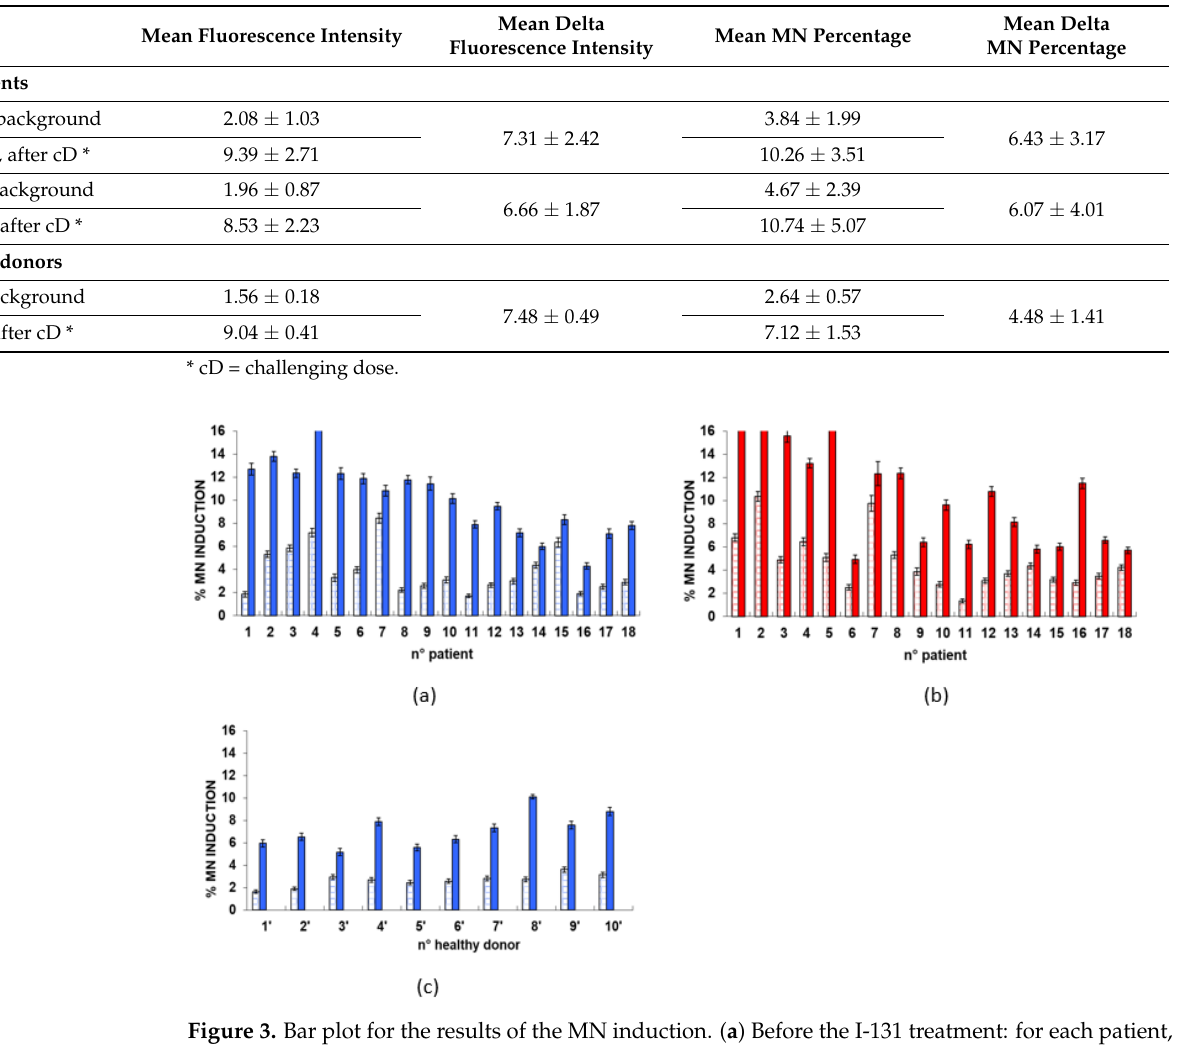
Table 1. Results for the γ -H2AX and for the MN induction assays.